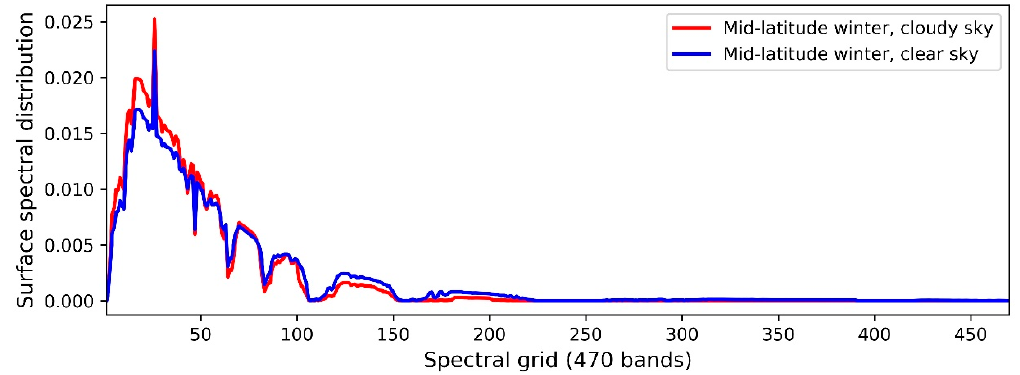
Figure 1. Incident solar flux surface spectral distribution.